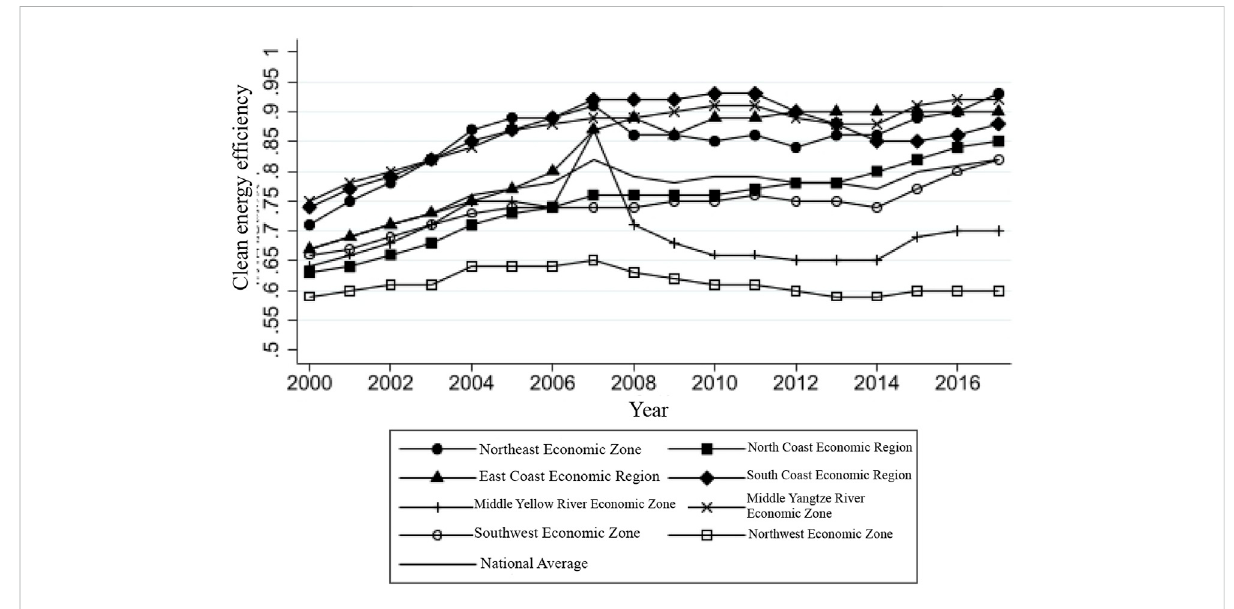
FIGURE 8 2000-2017 green and clean energy ef fi ciency structure of China ’ s eight economic zones (baseline grid emission